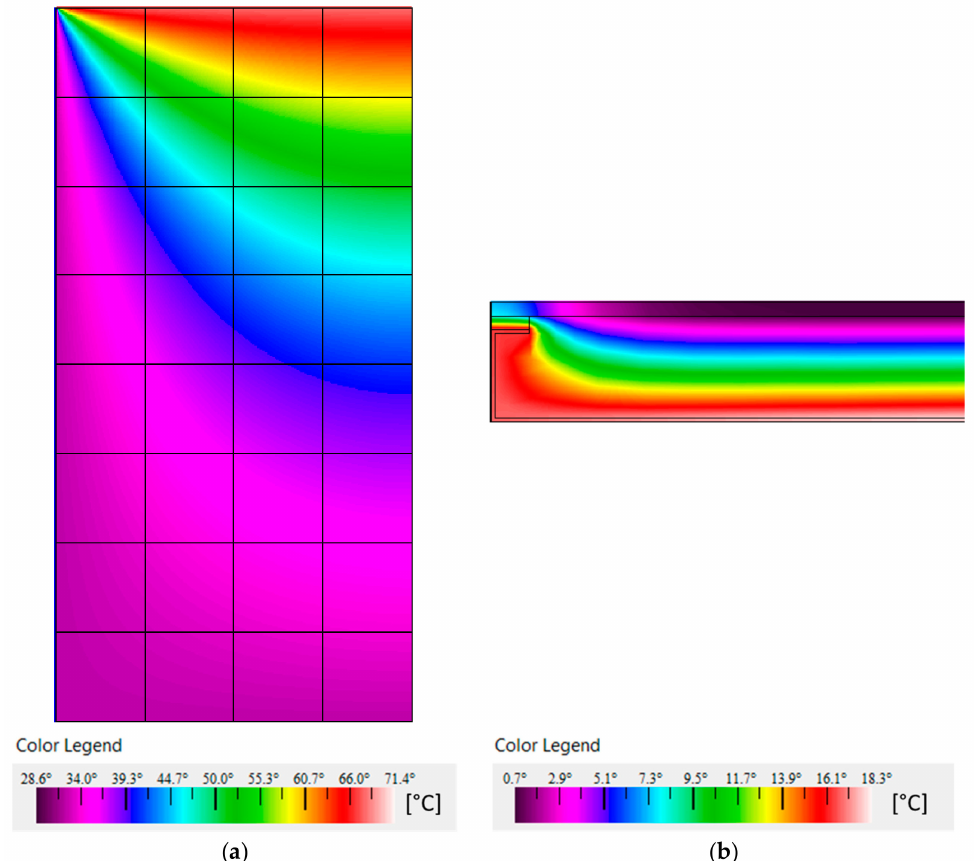
Figure 6. Temperature distribution obtained by the authors for the 2D test cases of ISO 10211 [22]: ( a ) test case 1; ( b ) test case